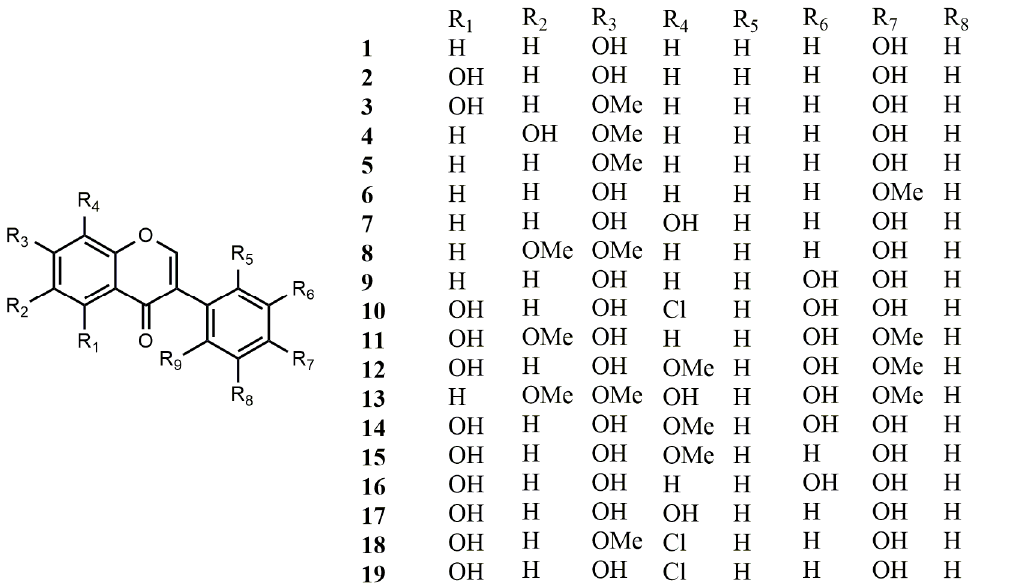
Figure 1. Reported structures of simple isoflavones 1 – 19 from fungi and actinomycetes.